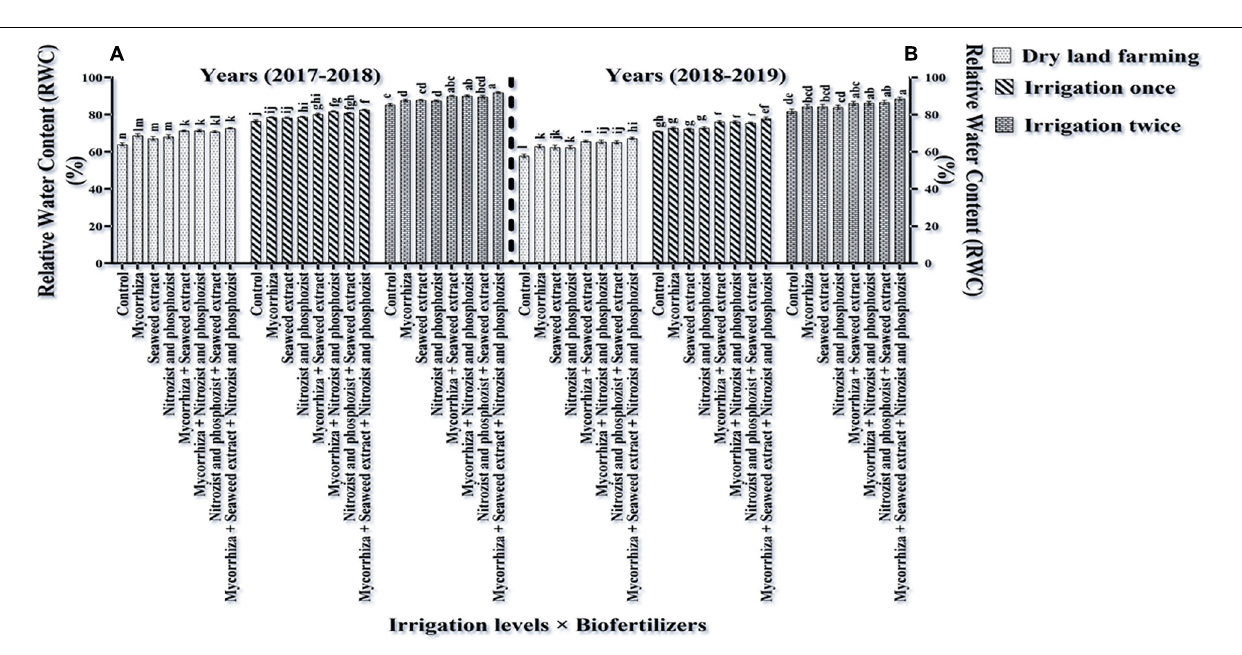
FIGURE 4 | Mean comparisons of the dual interaction effect of irrigation × biofertilizers on RWC trait in wheat plant in two seasons of experiment (A,B) (2017–2018 and 2018–2019). Means in each column followed by similar letter(s) are not significantly different at 1% probability level by the LSD